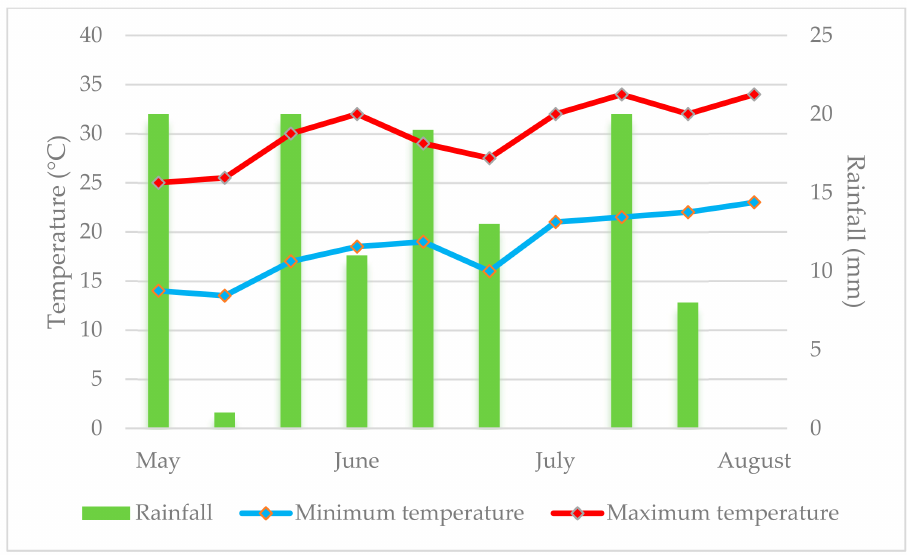
Figure 1. Ten-day means of temperatures and rainfall in Tavoliere delle Puglie (Italy) in 2018. A randomized complete block design with three replicates was applied in the field, tomato hybrid was the only experimental factor and the area of each plot was 65 m 2